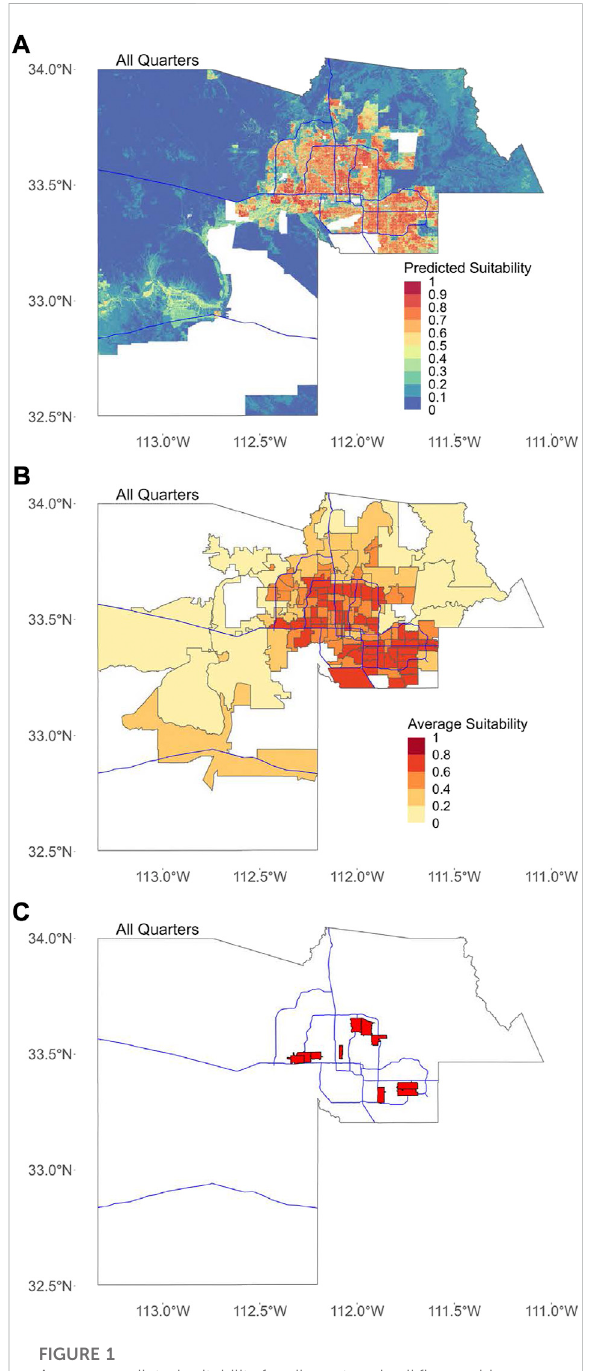
FIGURE 2 Binary maps for all quarters. In all fi gures, blue lines represent major freeways in Maricopa County as a spatial reference. (A) The consensus binary map for all quarters created by overlaying the binary map for all 25 quarters. Areas with missing data where suitability was not predicted are shown in white. (B) Proportion of areaineachZCTApredictedassuitablebasedonbinarymapin (A) . (C) The location of ten ZCTAs with the highest proportion of area predicted as suitable for all